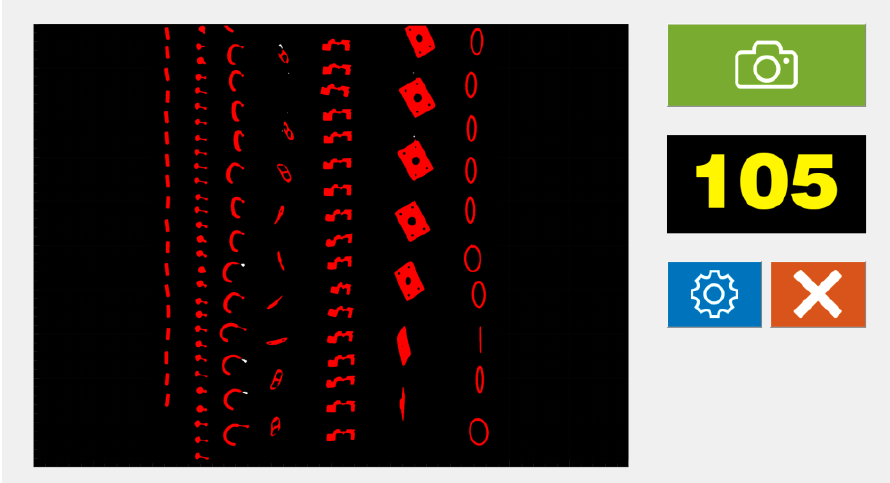
Figure 15. Dedicated GUI implemented for controlling the counting machine performance. On the left, it is possible to read the number of items. Moreover, it is possible to save the screened image (green camera icon) and to close the application (red X in figure). The user can also access a setting panel (blue gear icon) in case they want to set a different threshold value for the algorithm.